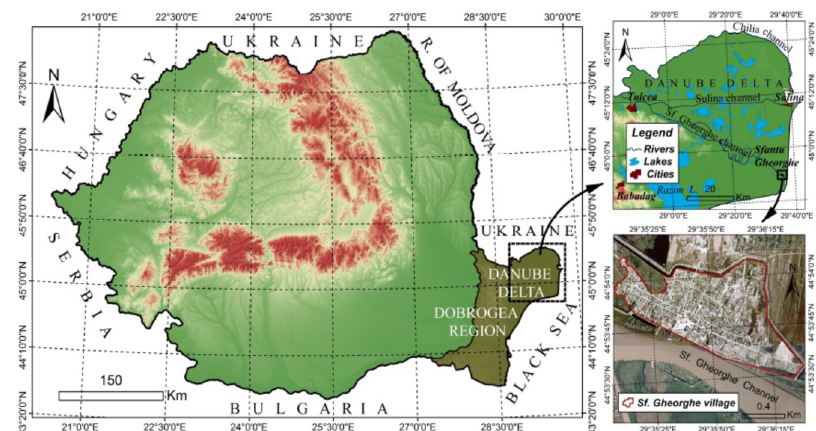
Fig. 1. Location of study area: Sfântu Gheorghe, Delta Dun ă rii.